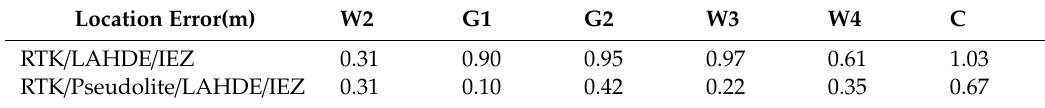
Figure 15. The trajectories of indoor corridor and indoor room parts ignoring positioning error at point B. Table 4. Comparison of location errors of Person A.